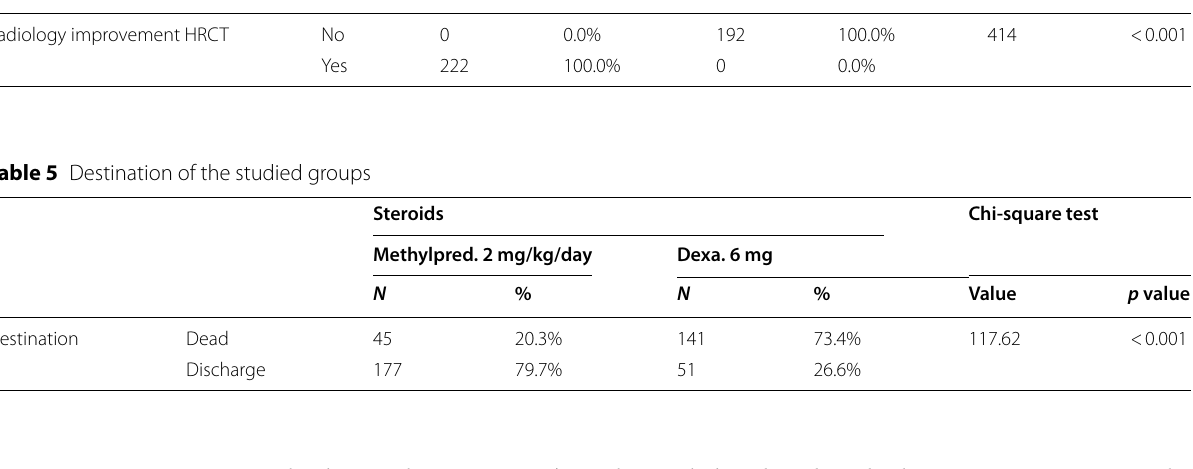
group versus 26.88 value < 0.001).